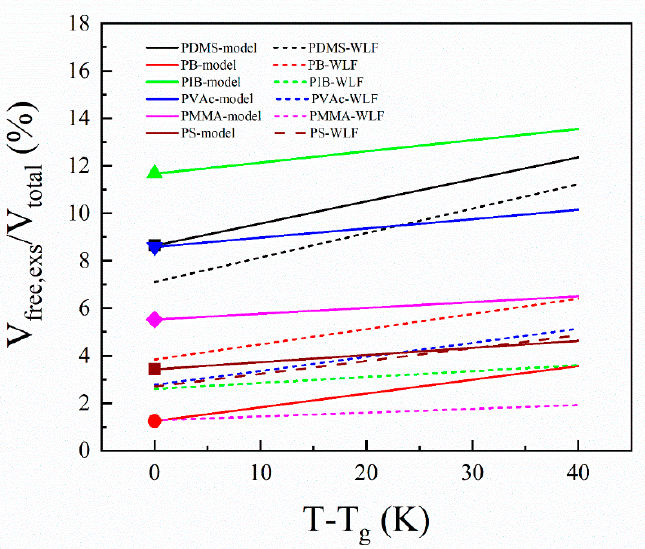
Figure 4. The comparisons of the temperature-dependent fractional excess free volume between the calculation results from Eq. 6 or 7 with Eq. 8 (solid lines) and WLF results in the literature (dotted lines) for six polymers (the parameters are listed in Table 1 and Table S1). Table 1. The temperature-dependent fractional excess free volume when it is close to glass formation. Calculation results according to both our model (Equations (6) or (7) and (8)) and WLF equation in the literature (if α G could not be found in the literature, only α L was used).